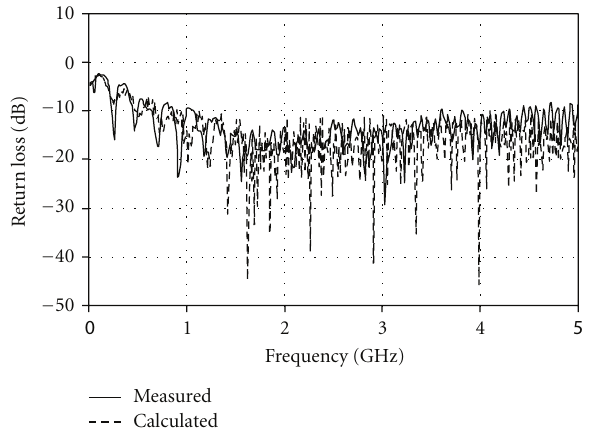
Figure 5: Comparison of measured results and those of a simula- tion for N e = 4 with a narrow throat. Simulation results show similar tendency to measured ones.